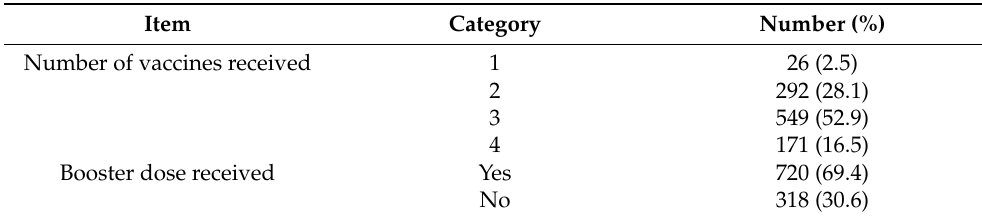
Table 4. Number of COVID-19 booster dose